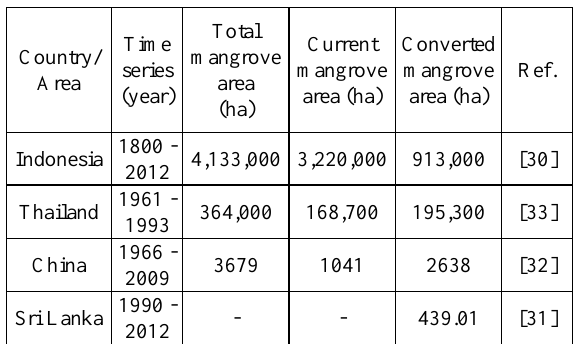
Table 1. Estimated changes of mangrove